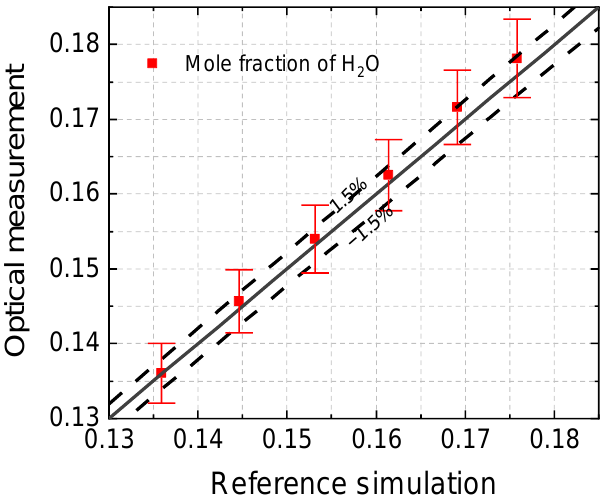
Figure 11. Mole fraction of H 2 O in combustion exhaust gas measured using absorption spectroscopy versus equilibrium calculation using Chemkin with an equivalence ratio of 0.99 – 0.73.